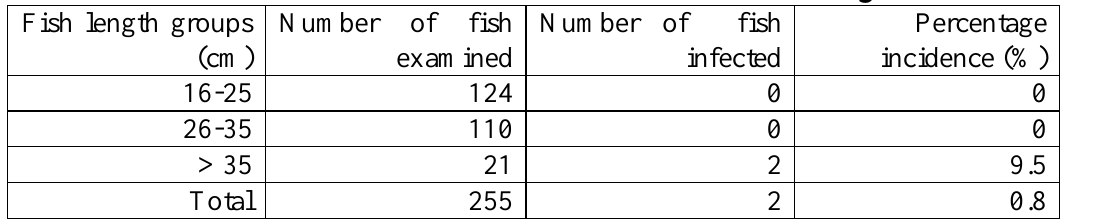
Table (2): Percentage incidence of different length groups of C. carpio with two species